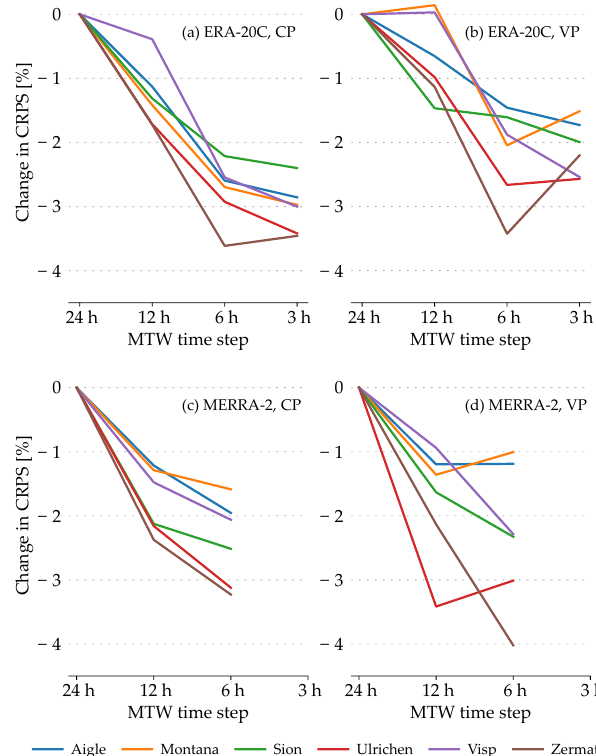
Figure 9. Changes in performance score (CRPS) of the 2Z method at the different stations for MTW of varying time steps relative to the conventional approach of 24h. Results are provided for ERA- 20C for the (a) CP and (b) VP as well as for MERRA-2 for the (c) CP and (d) VP. Lower CRPS values indicate better